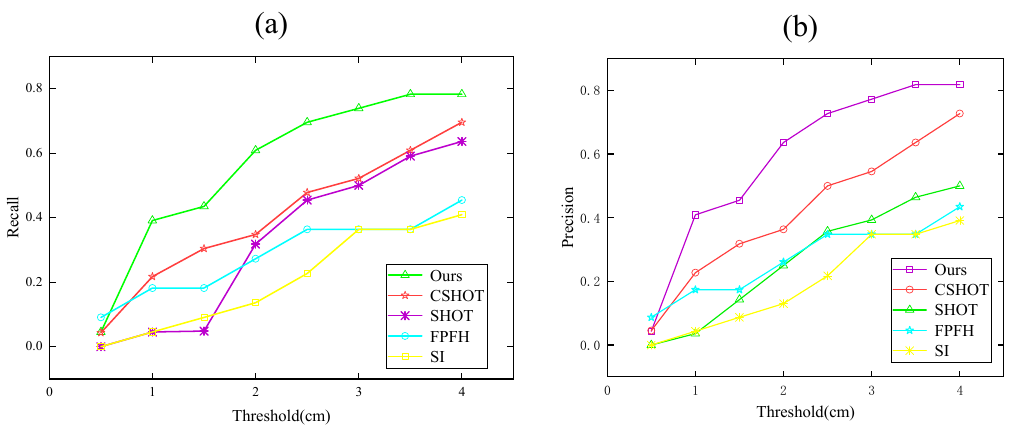
Figure 11. Algorithm comparison; ( a ) Recall; ( b ) Precision.